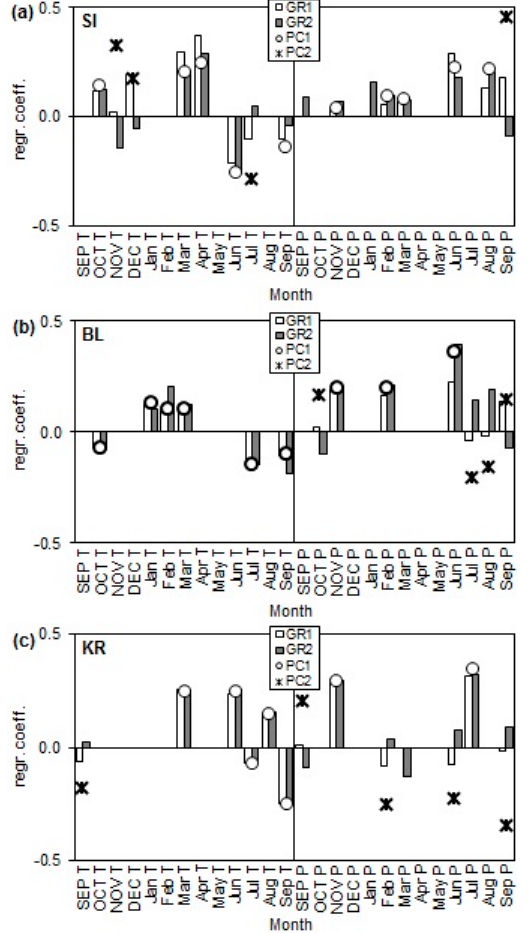
Figure 6. Significant ( p < 0.05) multiple regression (response function) coefficients calculated for the yearly scores of PC1 and PC2 and the mean indexed chronologies of the larch provenances from groups 1 (GR1) and 2 (GR2) for the provenance trials in Siemianice—SI ( a ), Bli˙zyn—BL ( b ) and Krynica—KR ( c ). Independent variable were the mean monthly air temperature (T) and total monthly precipitation (P) from the previous September (SEP) to the current September (Sep) for the period of 1971–2015. R 2 —determination coefficients.